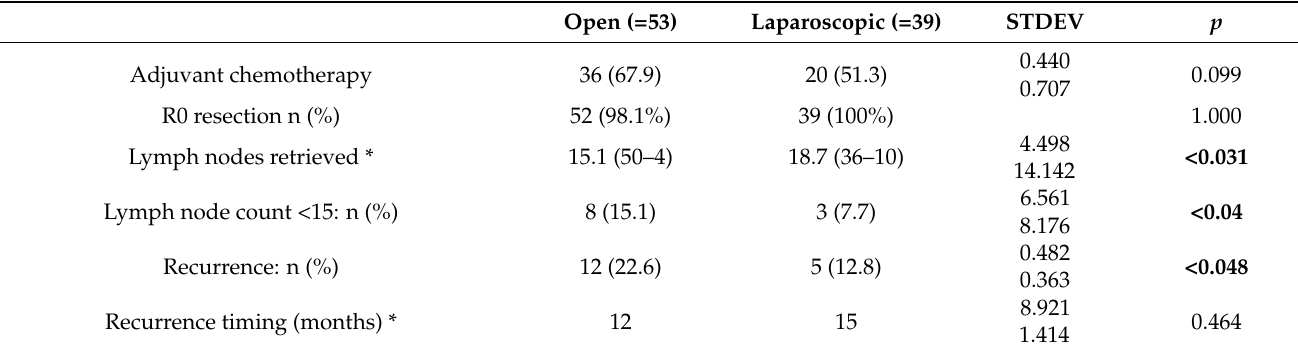
Table 3. Oncological results of the two groups: univariate